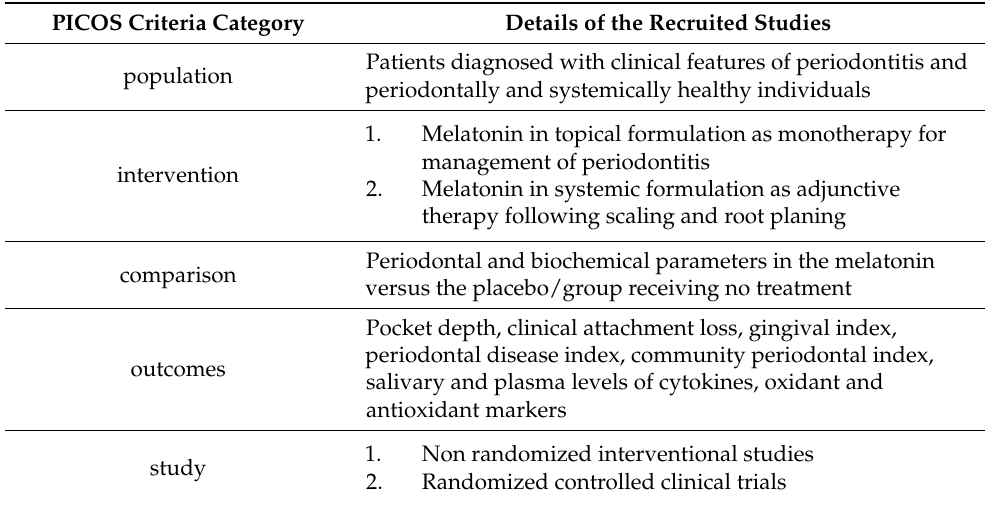
Table 1. PICOS criteria for the recruited